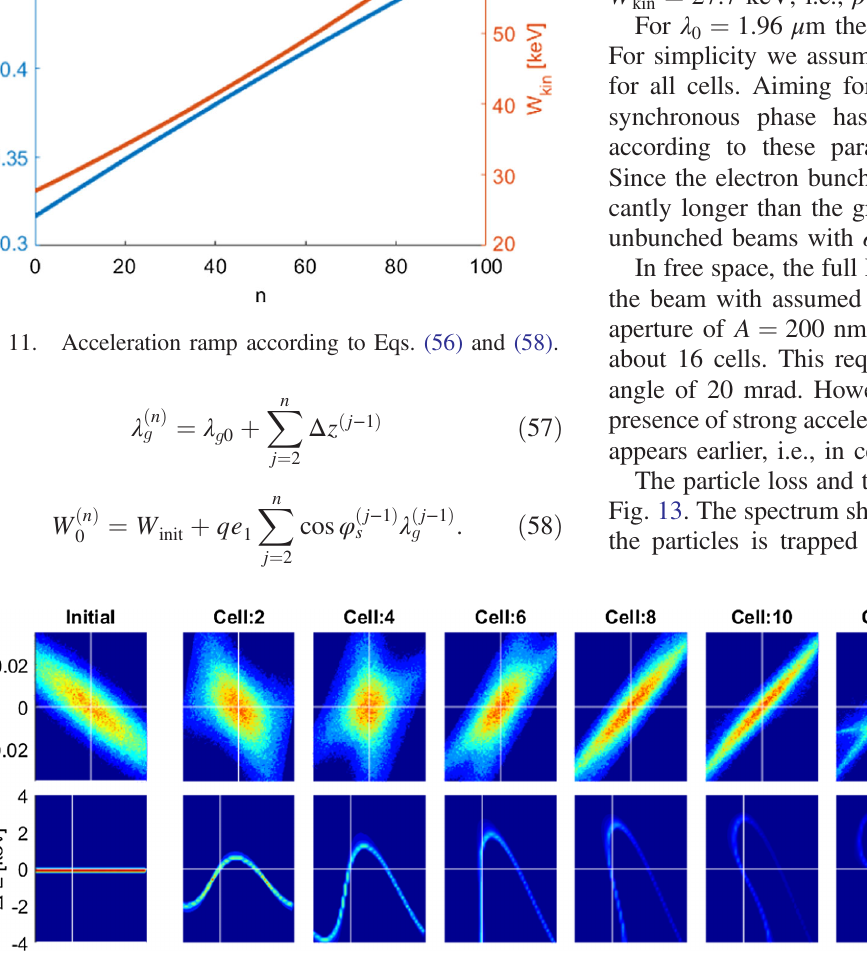
FIG. 12. Longitudinal (bottom) and transverse (top) phase space for 16 cells of the chirped grating with an initially unbunched beam, focused into the structure. The axes are − 100 nm < y < 100 nm and 0 < φ < 2 π . The color represents the phase space density, where the initial plots are normalized to their maximum and all other plots are normalized to the respective maxima of the second column.